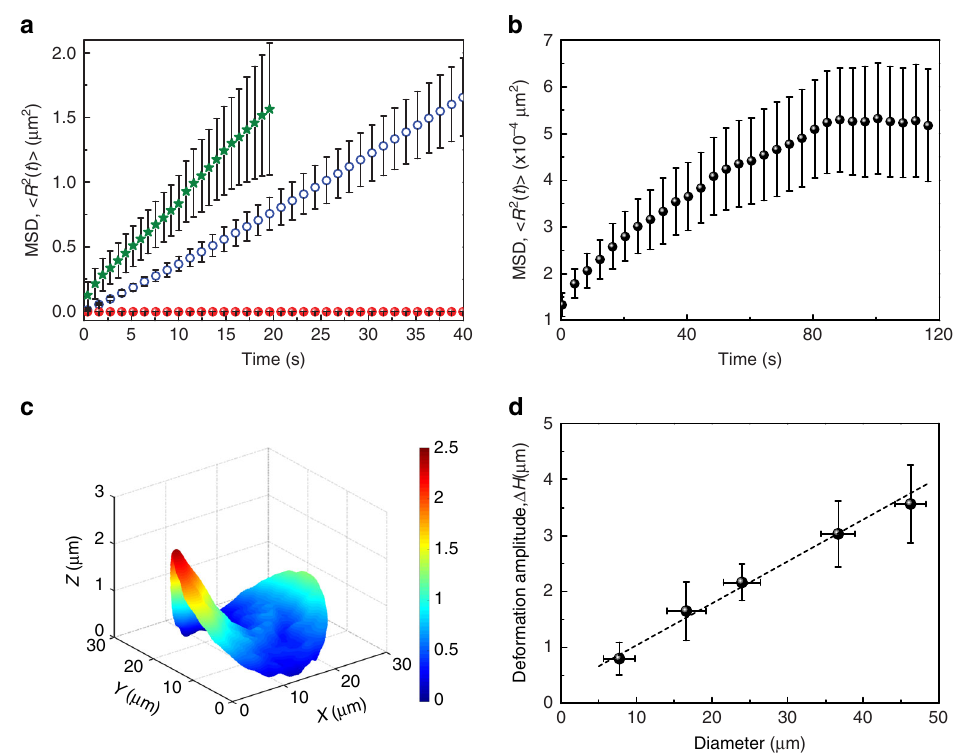
Fig. 3 Dynamics and macroscopic structure of crystalline colloidal membranes. a Mean squared displacement (MSD) as a function of time for rods within the bulk of a crystalline membrane (red closed circles), bulk of a fl uid membrane (blue open circles), and rods at the edge of the crystalline membrane (green stars). b Zoomed-in MSD of the rods within the bulk of the crystalline membrane. MSD of rods in the bulk of the crystalline membranes, bulk of the fl uid membranes, and edge of the crystalline membranes was obtained by analyzing the individual trajectories of 186, 102, and 50 tracer rods, respectively, present across multiple membranes and multiple sample chambers. The average of all these data sets is plotted in symbols with the standard deviation as the error bar. c 3D rendered confocal image of a crystalline colloidal membrane formed out of a single nucleation center. Sidebar shows the color code for z -axis values. d Deformation amplitude, Δ H = H − H max min as a function of diameter of the colloidal membrane. The raw data corresponding to different membrane diameters were binned to compute a mean deformation corresponding to a mean membrane diameter. The standard deviation of a particular bin has been used as the error bar for that